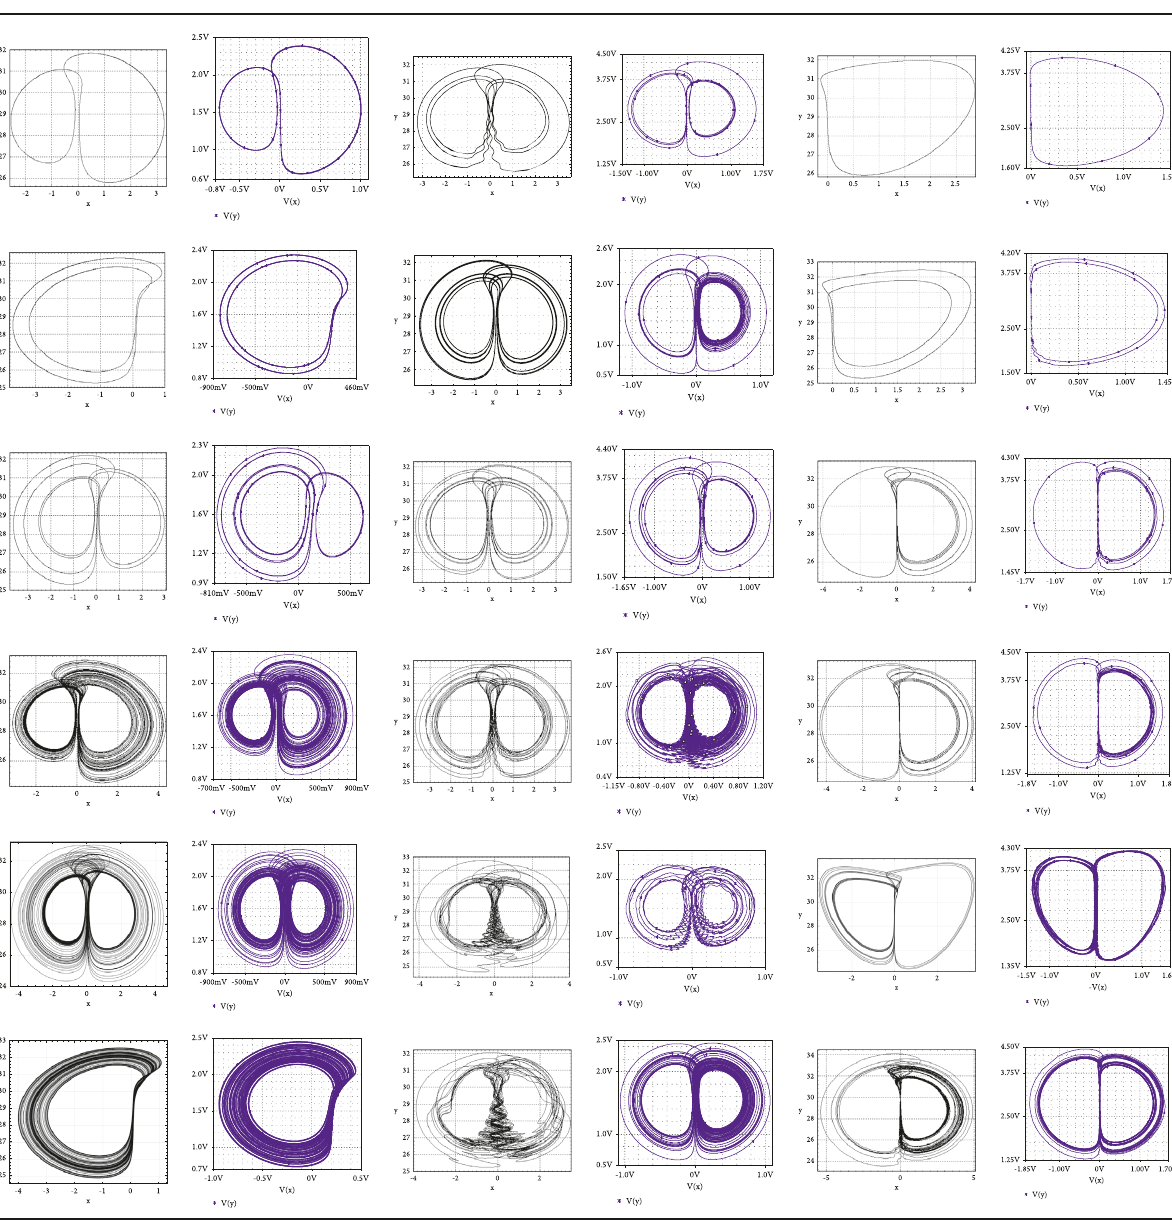
Figure 24: Phased portraits of numerical result compared to experimental